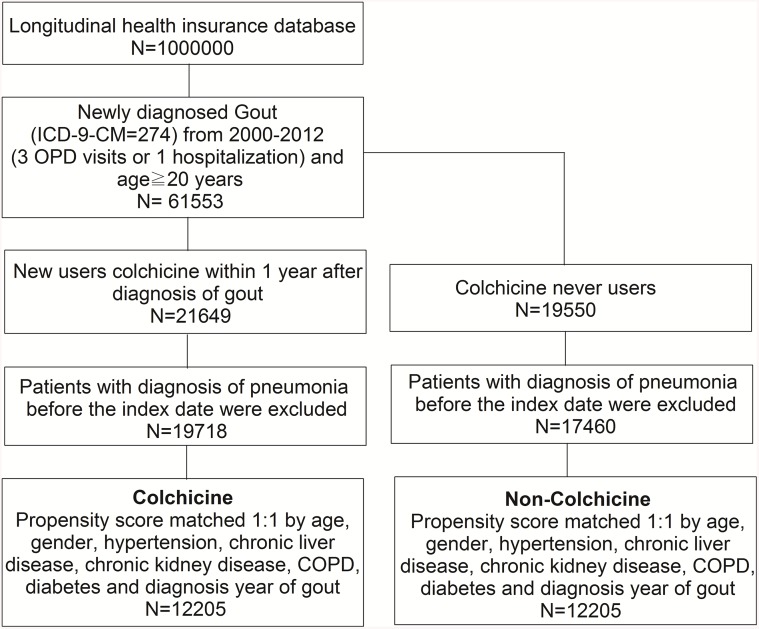
The study population selection protocol.